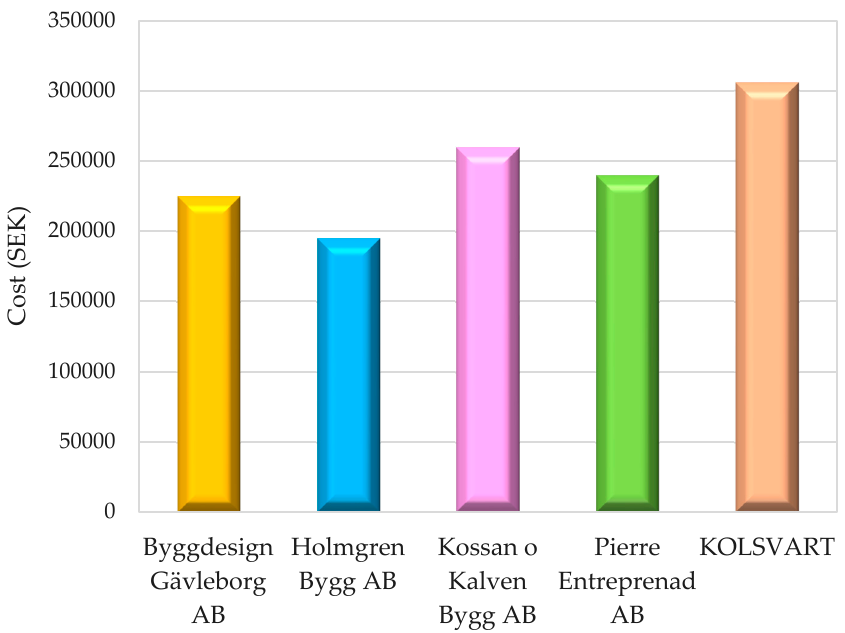
Figure 5. Differences in total costs for change and construction of a new wooden facade performed by companies (All the total costs considered by companies are for the change of a facade except the case of KOLSVART, which is for construction of a new facade).